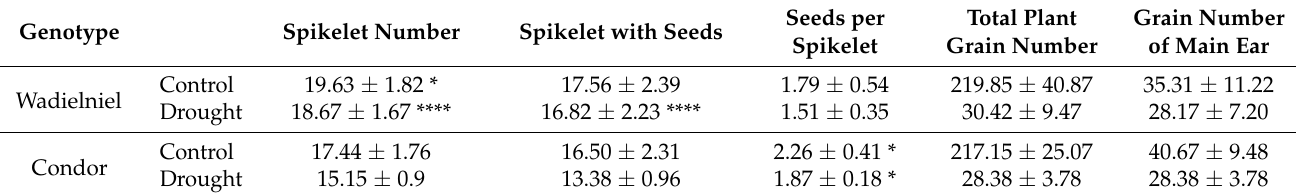
The thousand-kernel weight (TKW) of the main ear and the average seed area were seed width and length (Table